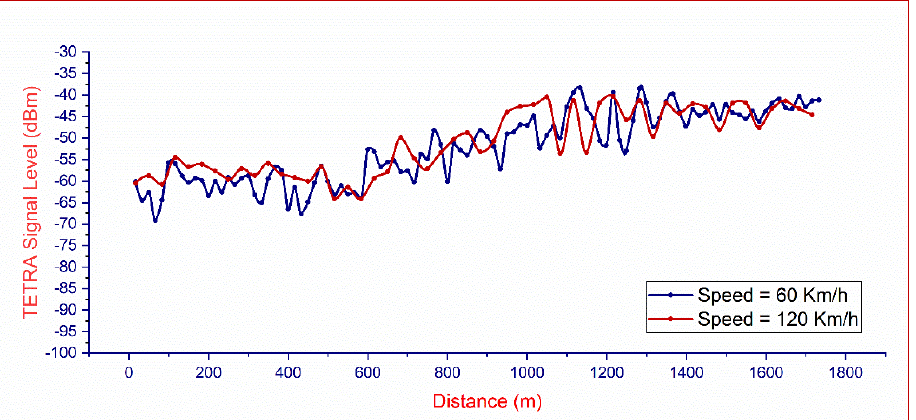
Figure 17. TETRA channel measured power with the mobile sensor: the speed is not influencing the correctness of the readings—exemplified by the speeds of 60 and 120